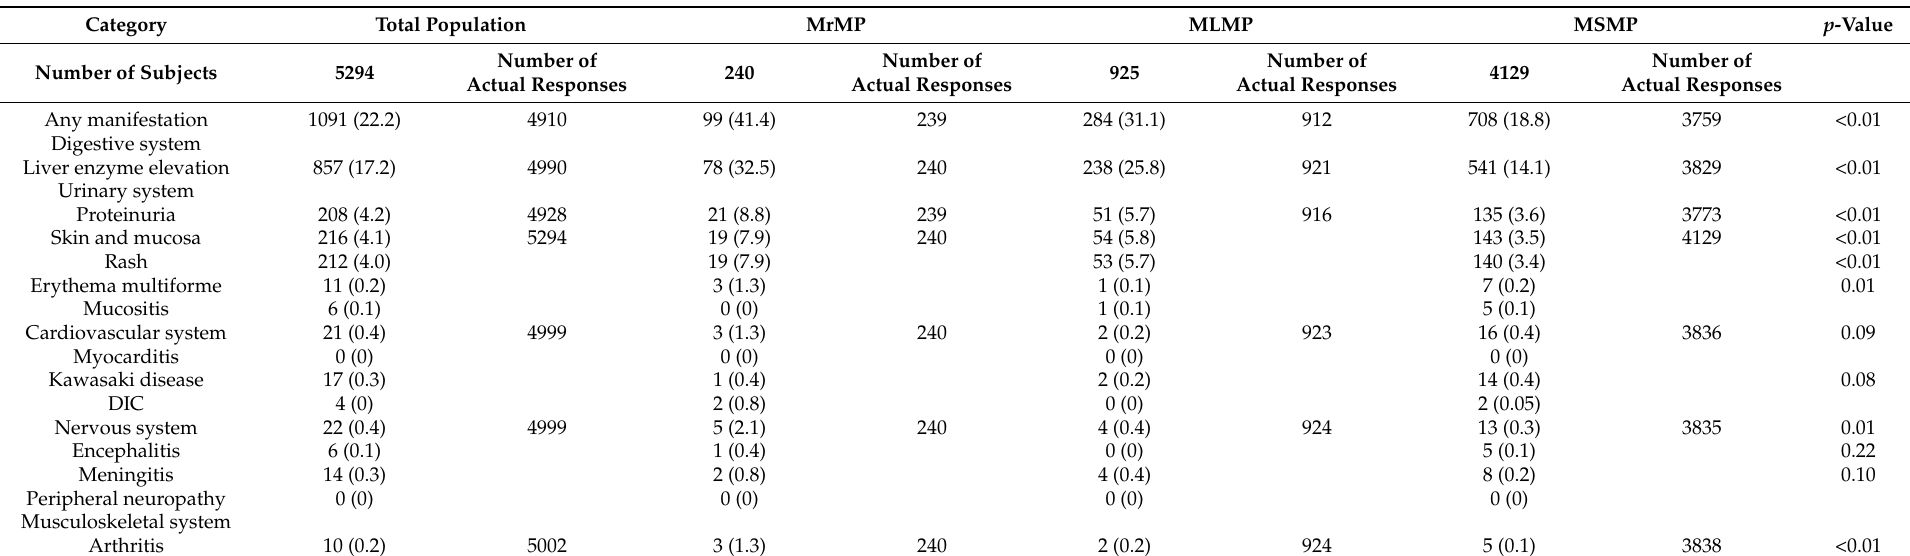
Table 6. Extrapulmonary manifestations.